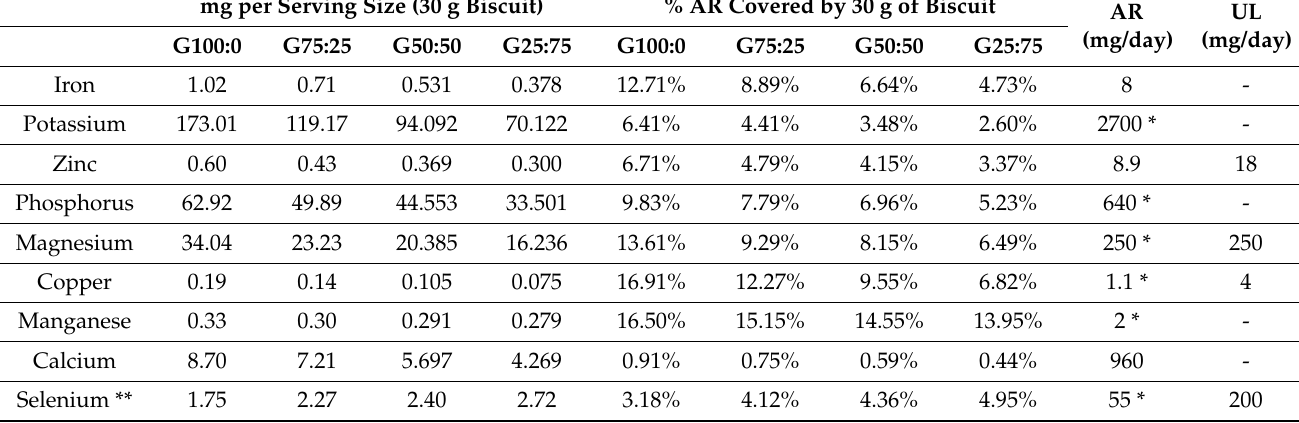
Table 9. Micronutrient content per serving size (30 g of biscuit), % of AR covered by a serving size and DRVs for micronutrients recommended by EFSA, for adolescents from 11 to 14 years, engaged in all types of physical activity. The DRVs indicated are the UL (Tolerable Upper Intake Level), which is “the maximum level of total chronic intake of a nutrient from all sources judged to be unlikely to pose a risk of adverse health effects in humans”; and the AR (Average Requirement), which refers to “the intake of a nutrient that meets the daily needs of half the people in a typical healthy population”.